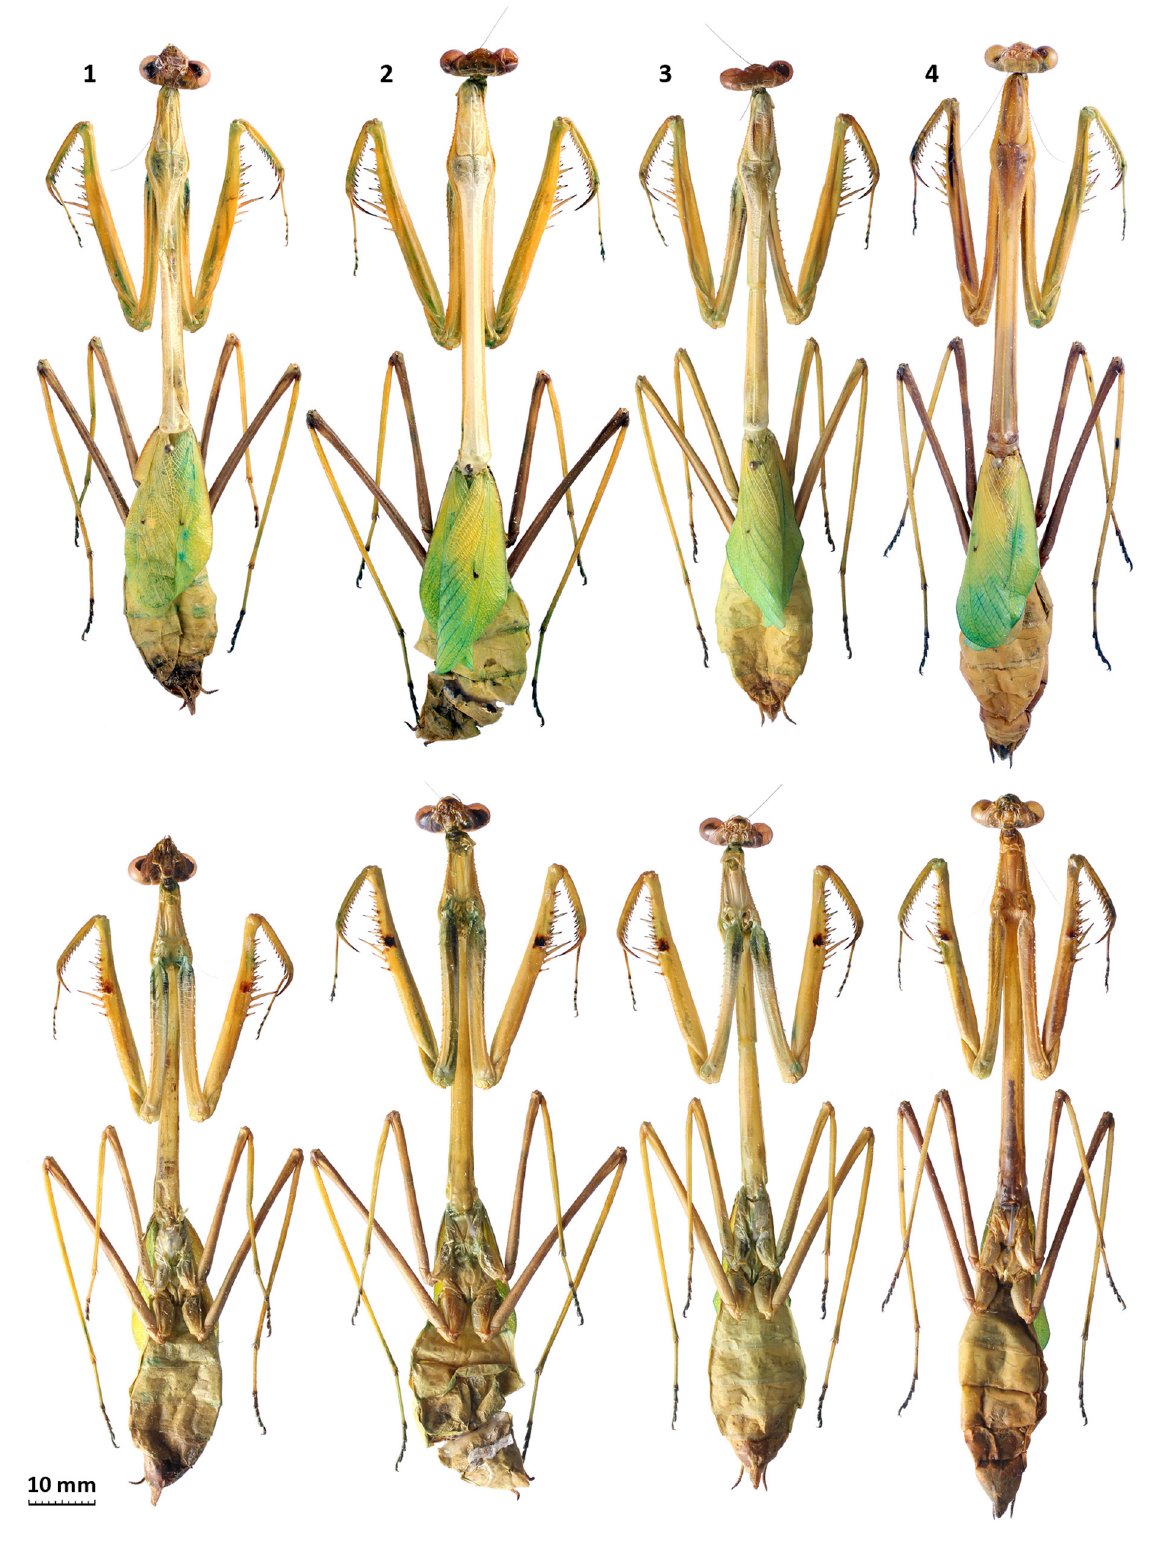
Fig. 4. Phasmomantella nuichuana sp. nov., dorsal and ventral views of paratypes